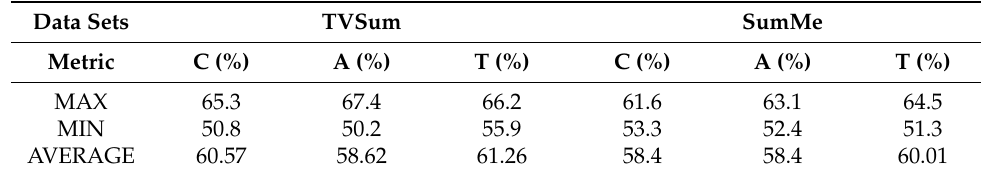
Figure 9. The A, C, and T results of TvSum. Table 3. Performance analysis of self-verification